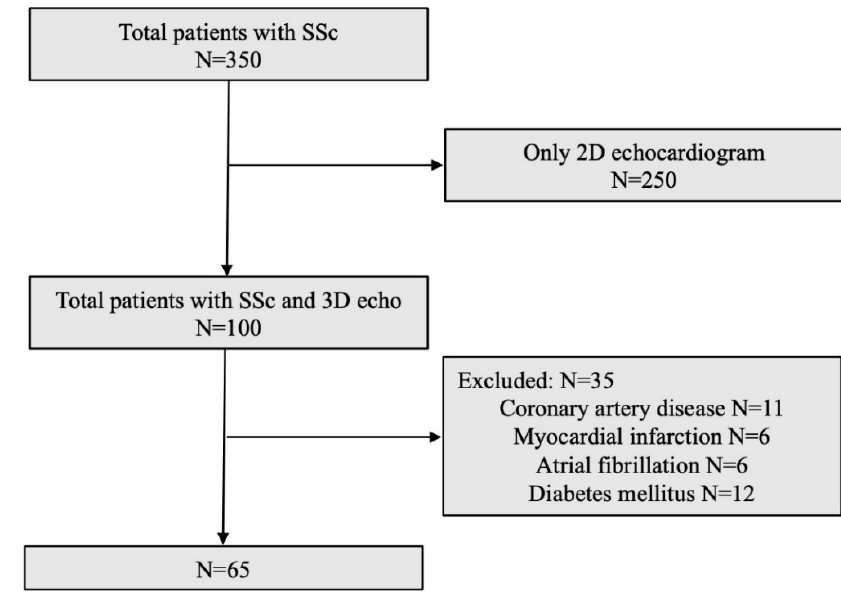
Figure 6. Study flow diagram. SSc, Sytemic Sclerosis.